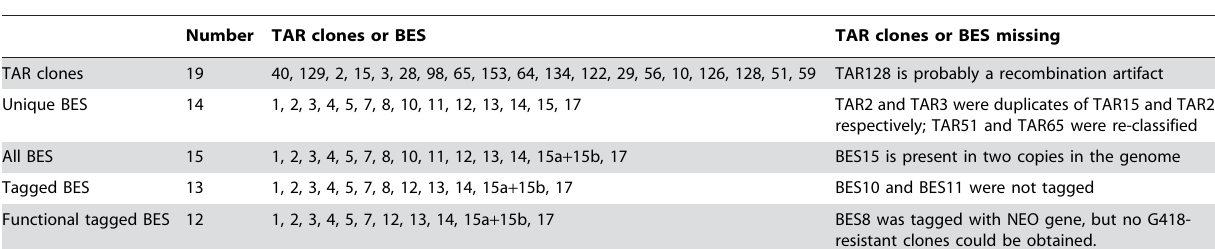
Table 2. Summary of the number of TAR clones sequenced, BES identified and BES activated.